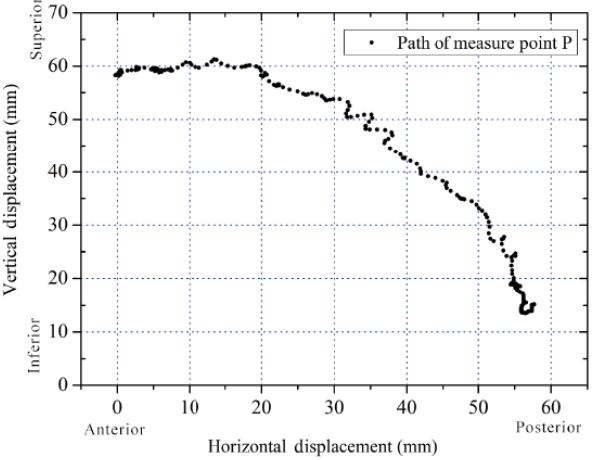
Figure 6. Trajectory of the measuring point. Table 1. Optimal design variables via GAs for minimizing x C